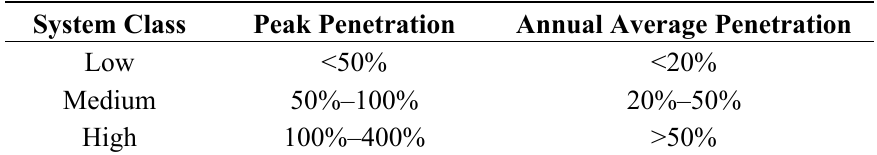
Table 1. Hybrid power system penetration